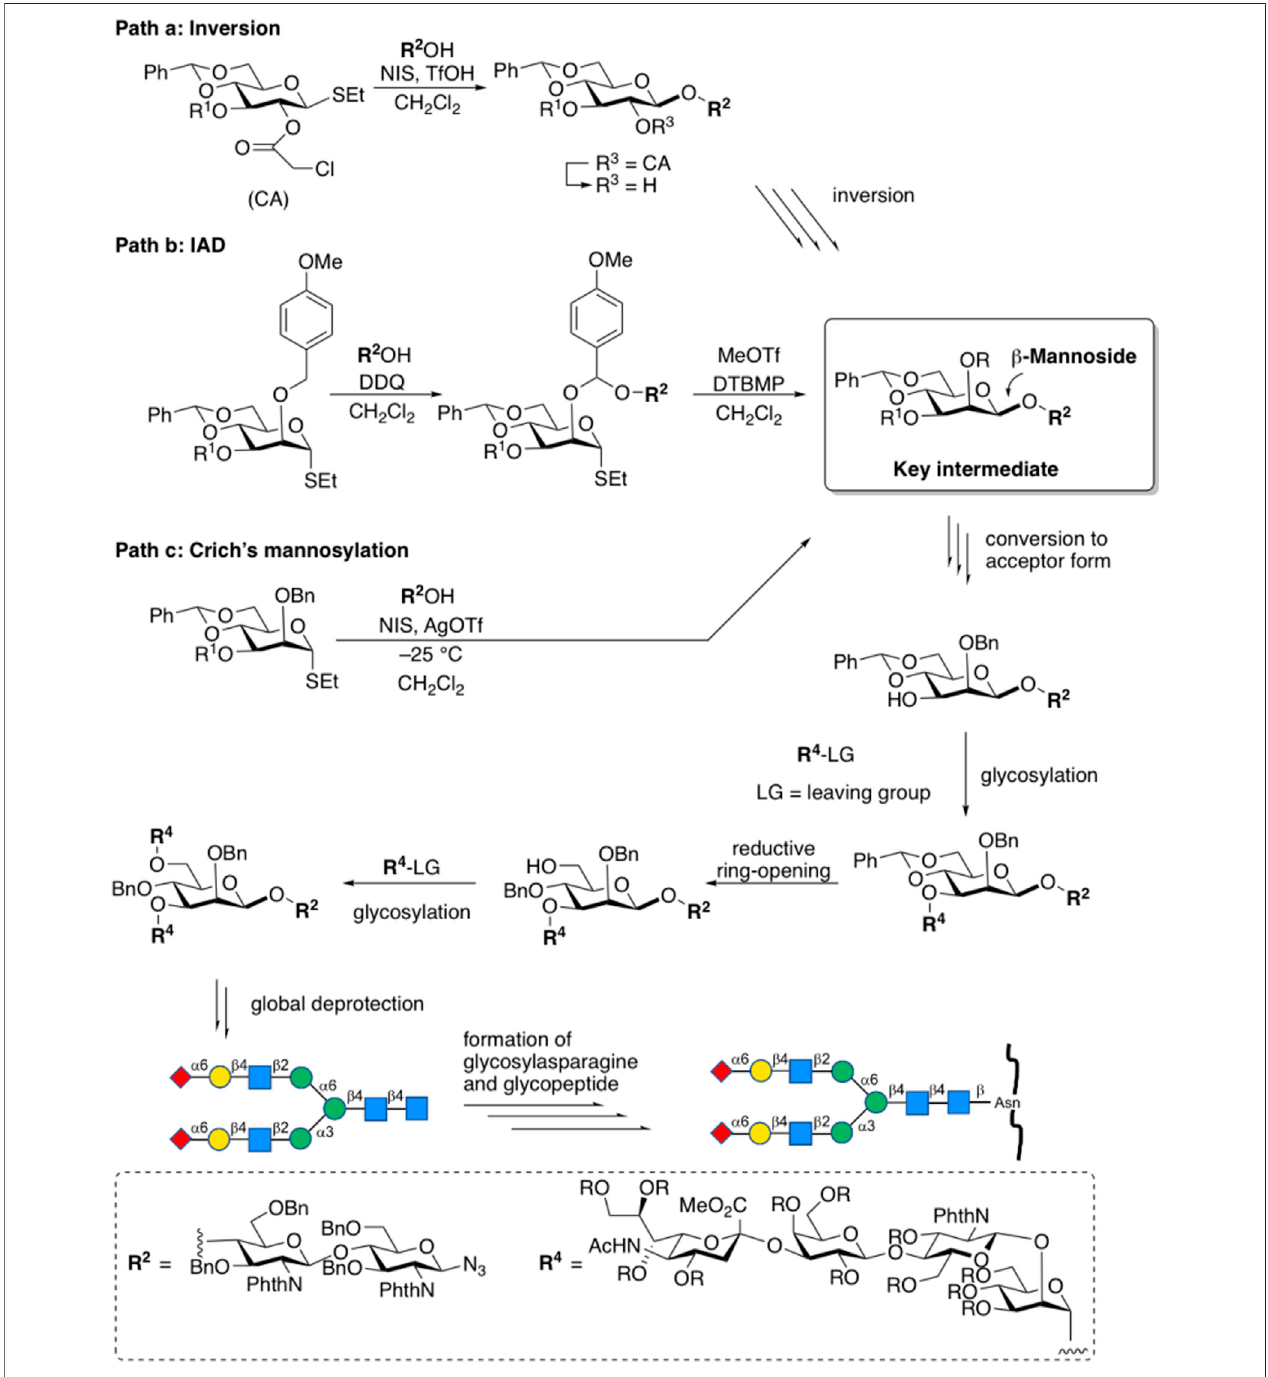
FIGURE 4 | Chemical strategies for the construction of β -d-mannosidic bonds in complex-type N -glycans.